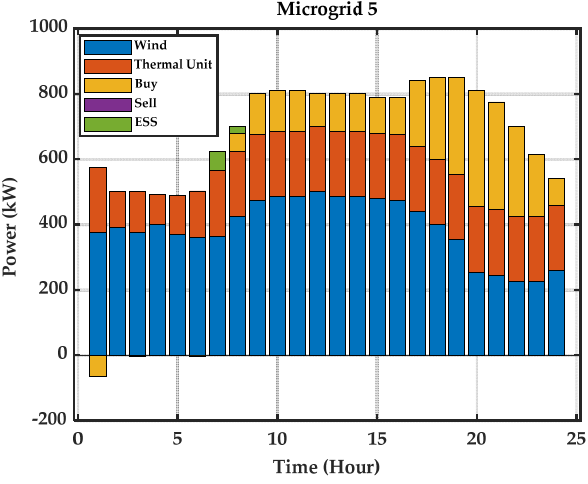
Figure 13. Load profile of MG5.